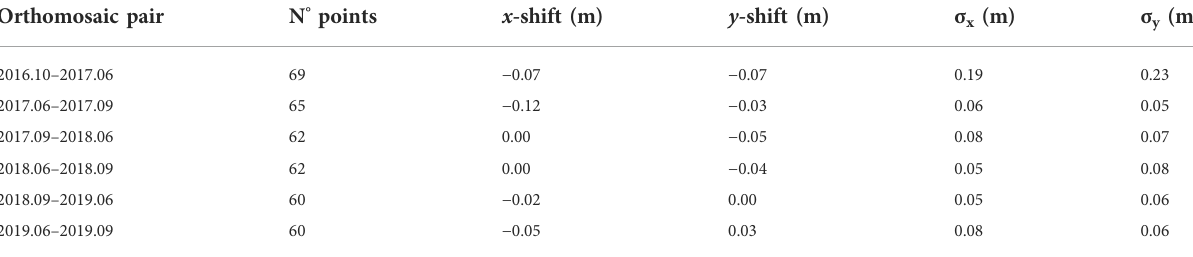
TABLE 3 Values obtained from the Helmert similarity transform available on CIAS between orthomosaic pair constituents. The points used for the evaluation are con fi ned to the stable sectors (see Figure 1C). Orthomosaic